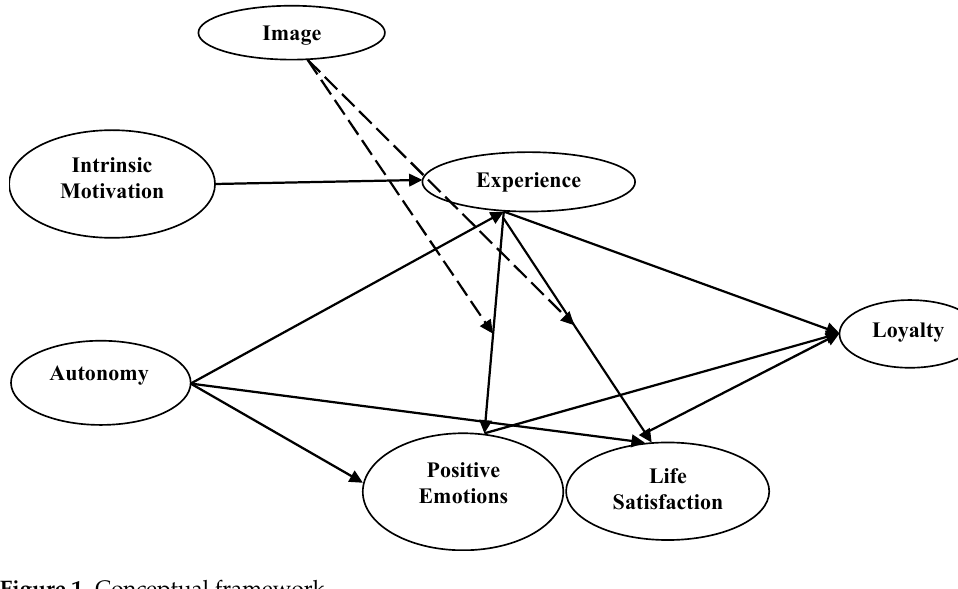
Figure 1. Conceptual